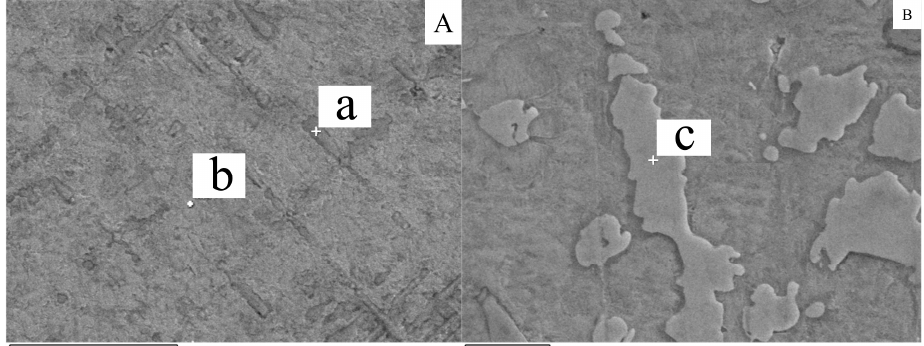
Figure 6. EDS scan single-layer sample element composition. ( A ) Top equiaxed crystal, a: branches of equiaxed crystals. b: Matrix of the sample. ( B ) Precipitated phase at the top of the sample. c: Mark points for measuring precipitated phase elements.